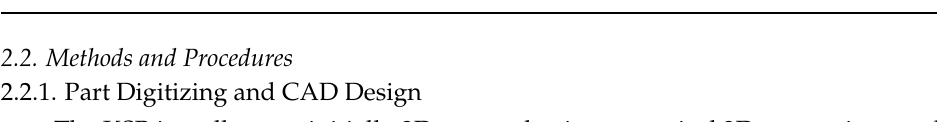
Table 1. Composition (%) of the cast stainless steel used in this work. Element Fe Cr